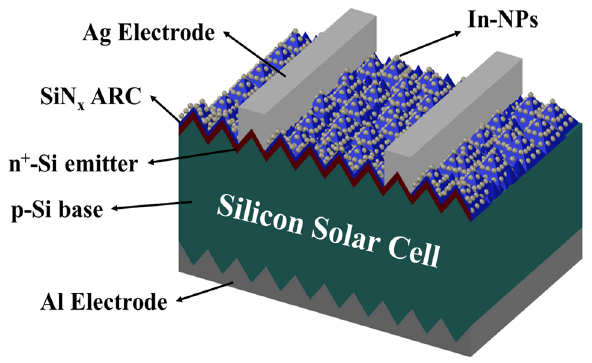
Figure 2. Schematic diagram showing textured C-Si solar cell coated with layer of In NPs.